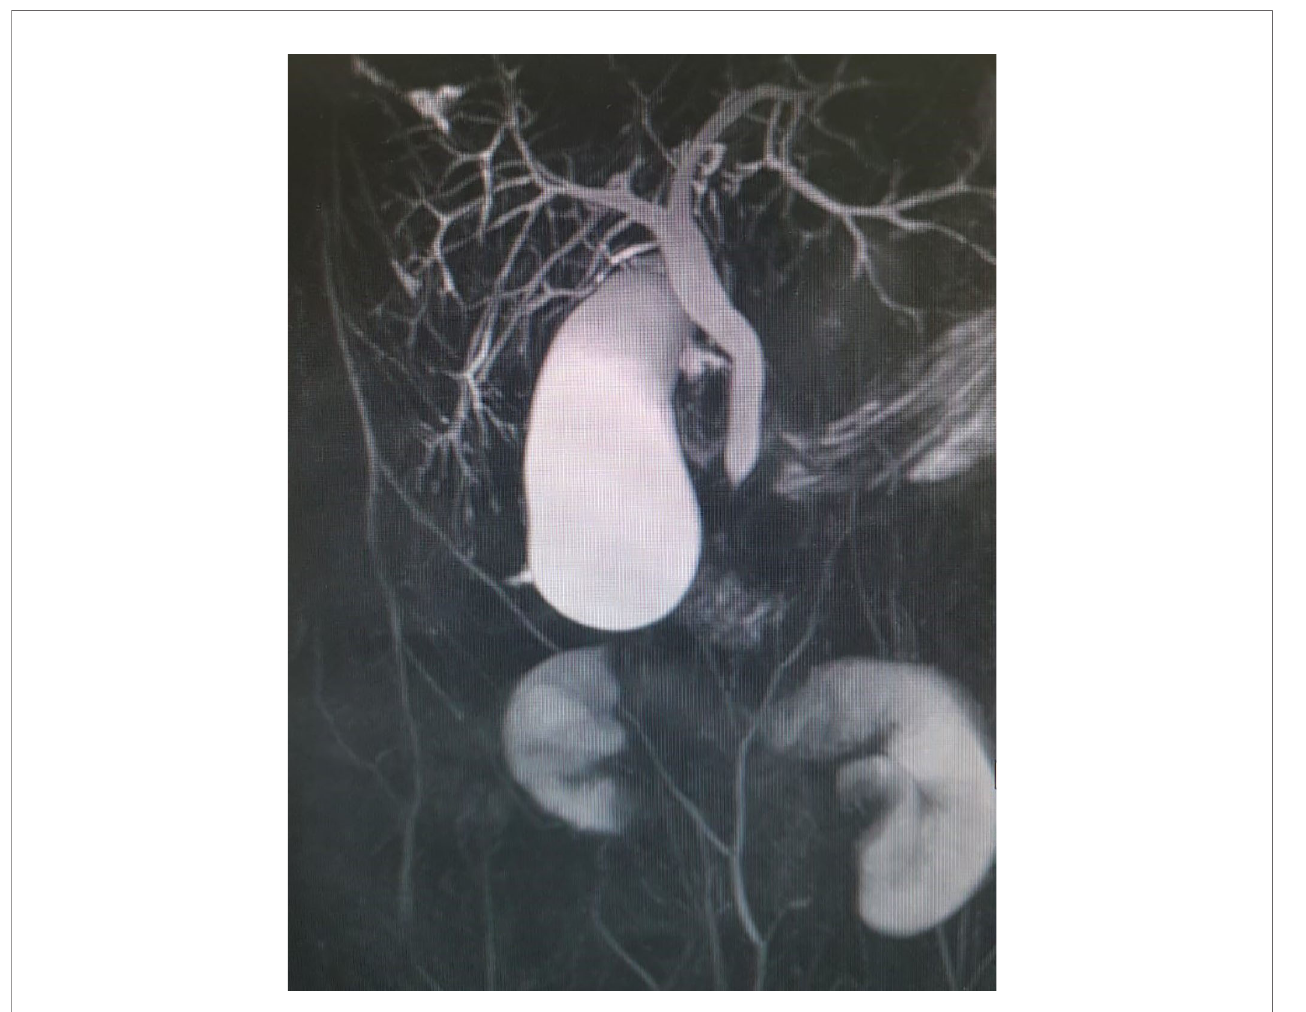
FIGURE 3 | Distended common bile duct and intrahepatic bile ducts on magnetic resonance cholangiopancreatography